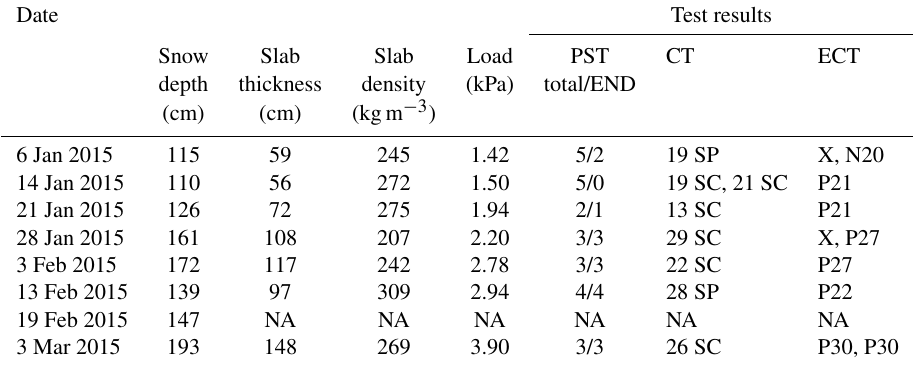
Table 1. Snowpack characteristics and snow instability test results on the 8 measurements days. For the PST the total number of tests and the number of tests with crack propagation to the end of the column, for the CT the score and the fracture type (SP: sudden planar, SC: sudden collapse) and for the ECT the fracture type (X: no fracture, N: initiation, but no propagation, P: propagation to column end) and the score are given (Greene et al., 2010). NA means not